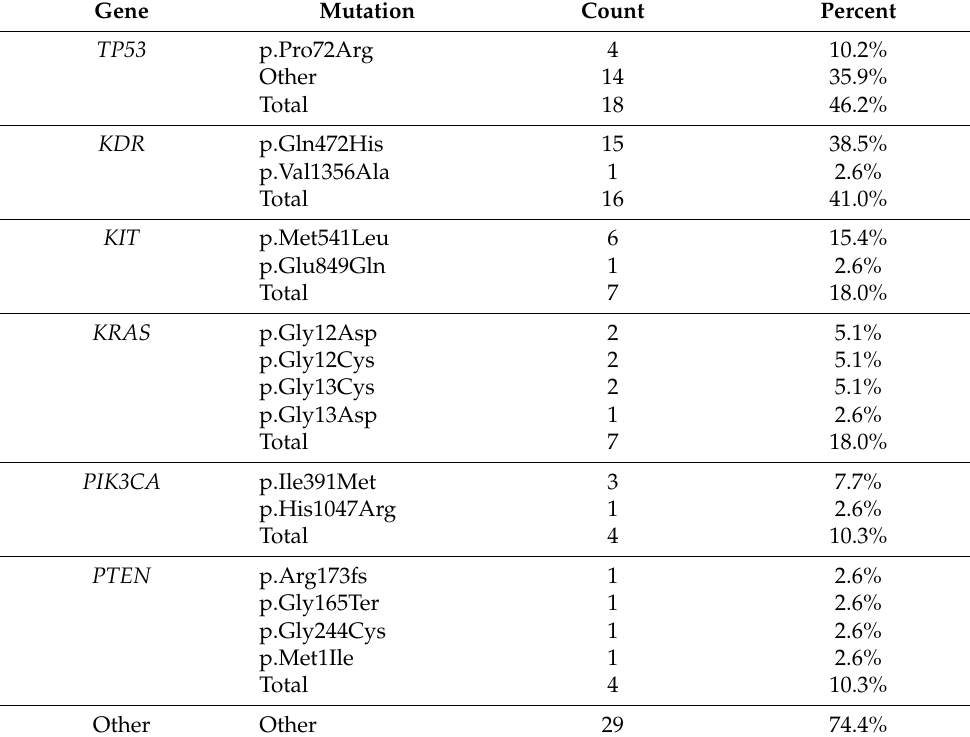
Table 4. Gene Mutation Frequency in Lung Cancer